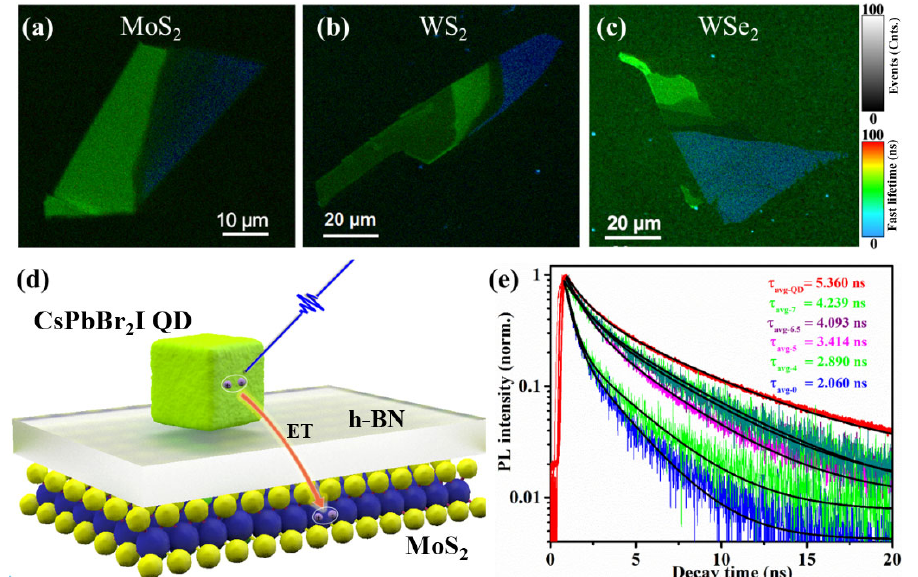
Fig. 9 (a, b, and c) Exciton radiative recombination lifetime of layered MoS 2 , WS 2 , and WSe 2 , respectively. (d) Schematic of the energy transfer process from QDs to MoS 2 . (e) Time-resolved photoluminescence (PL) decay traces in QDs/h-BN/MoS 2 heterostructure with different thicknesses of h-BN spacers. Reproduced with permission from Ref. [124] for (a, b, c), © American Chemical Society 2019; Ref. [125] for (d, e), © WILEY-VCH Verlag GmbH & Co. KGaA, Weinheim